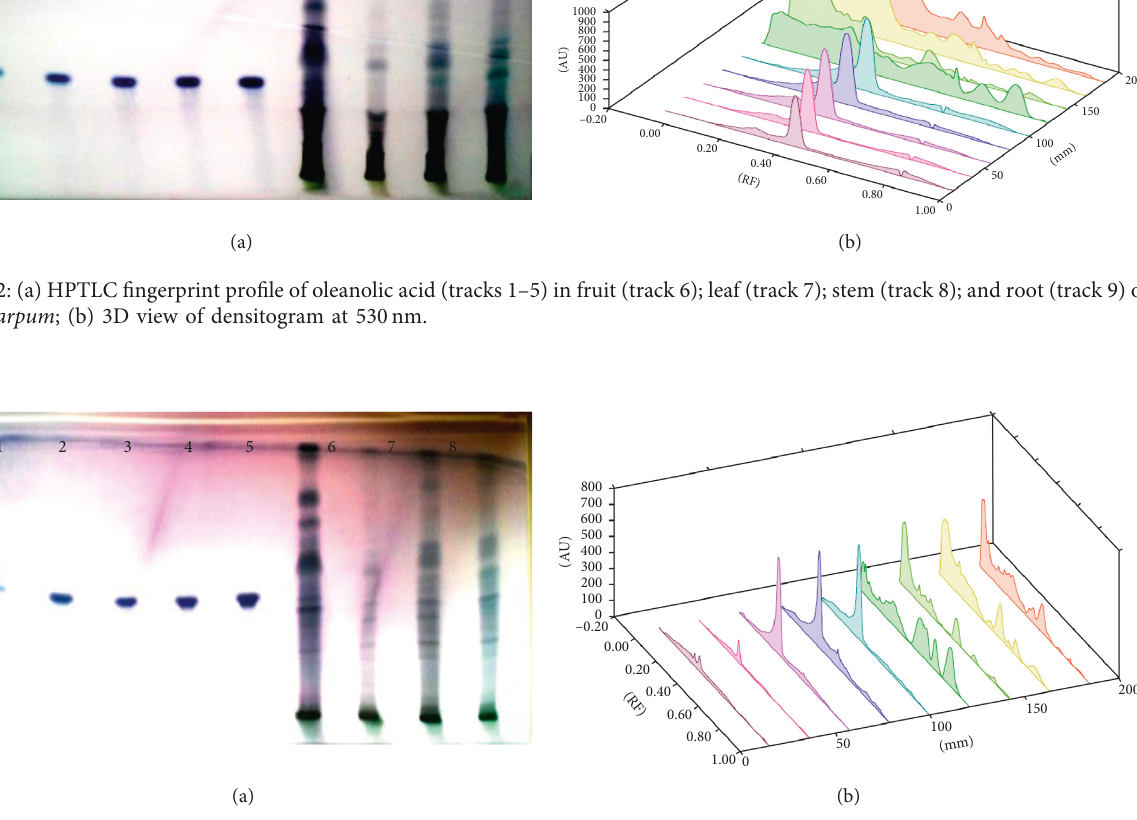
Figure 3: (a) HPTLC fingerprint profile of ursolic acid (tracks 1–5) in fruit (track 6); leaf (track 7); stem (track 8); and root (track 9) of S. xanthocarpum ; (b) 3D view of densitogram at